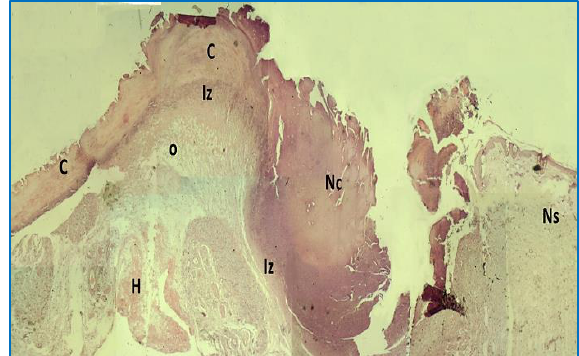
Figure, 2: Section of skin (7 days post injury-control) shows nflammatory zone (Iz), hemorrhage (H), fibrin clot (C), edema (O) and areas of normal skin (Ns). H and E 40x.